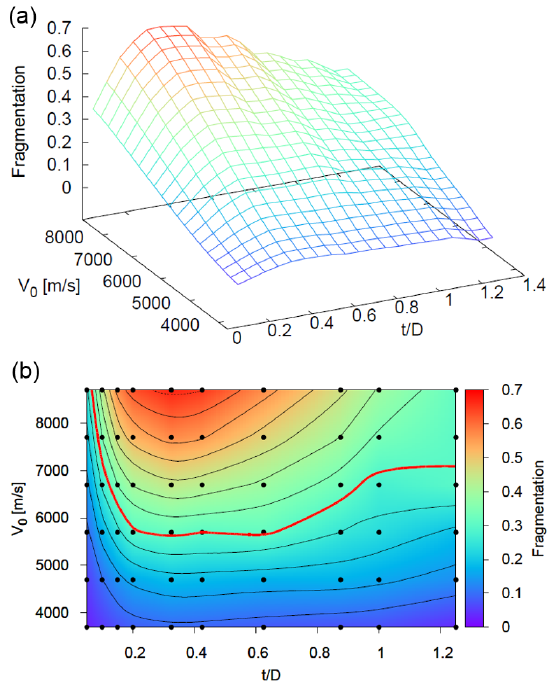
Figure 16. Fragmentation of the debris cloud at various t / D ratios and impact velocities v 0 . ( a ) Three–dimensional representation of fragmentation level; ( b ) Two–dimensional contour plot of fragmentation level. Black dots represent simulation points from which the contour surface was created and the red line is the fragmentation cutoff